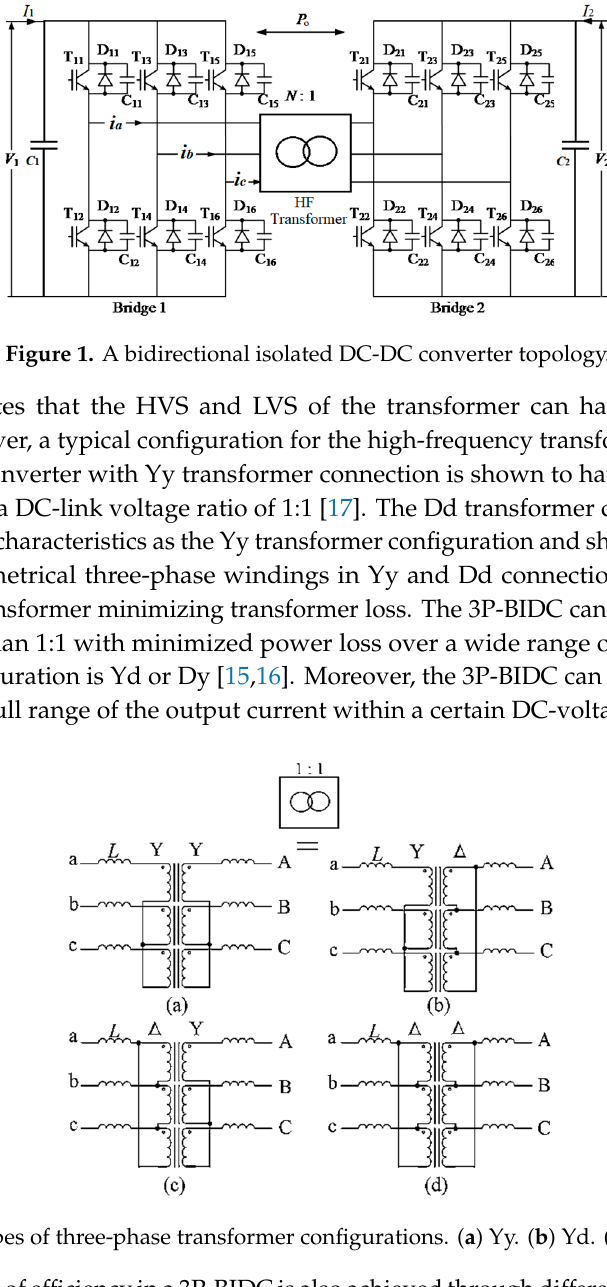
Figure 2. Types of three-phase transformer configurations. ( a ) Yy. ( b ) Yd. ( c ) Dy. ( d ) Dd.